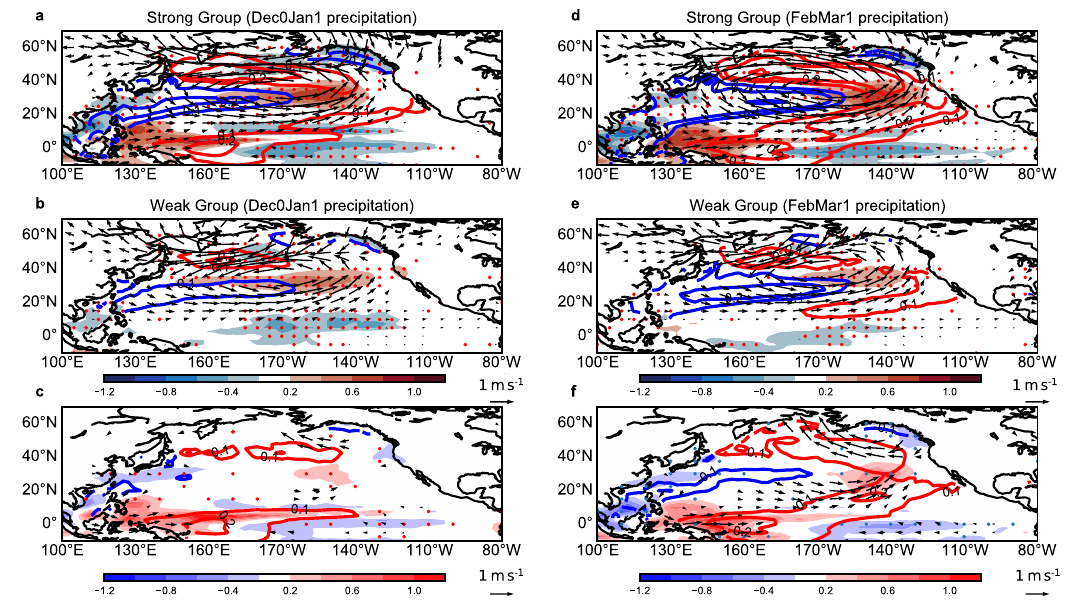
Fig. 5 Composite of SST, 850-hPa wind, and precipitation anomalies during December – January (left) and February – March (right) for the strong and weak MWAF groups. a Composite difference of SST (contour), 850-hPa wind (vector), and precipitation (shading) anomalies between positive and negative NPO events during December – January for the strong MWAF group. b Same as ( a ) but for the weak MWAF group. c Difference between the strong and weak MWAF groups during December – January. d – f Same as ( a – c ) but for February – March. The dots represent areas above the 90% con fi dence level for the precipitation, and the vectors are shown only with the zonal wind above the 90% con fi dence